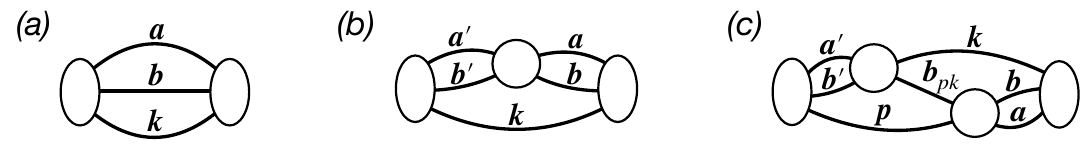
Figure 2 . Three Feynman diagram topologies required to illustrate the extension to generic isospin. including C 1 , A 3 and A 0 become (cid:13)avor matrices, even though the latter are de(cid:12)ned as 3 either scalars or vectors in the k‘m